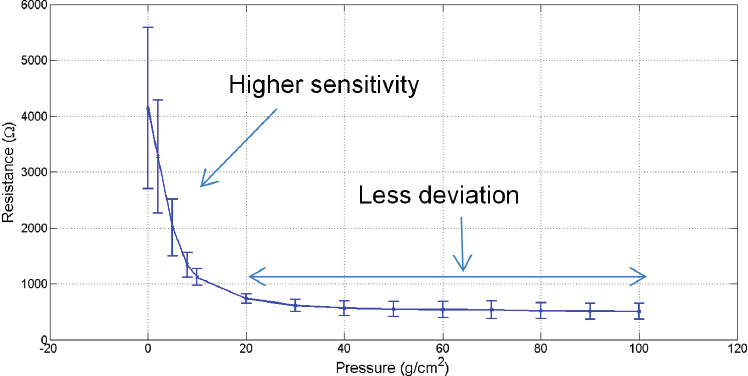
Figure 3. Sensors’ characteristic